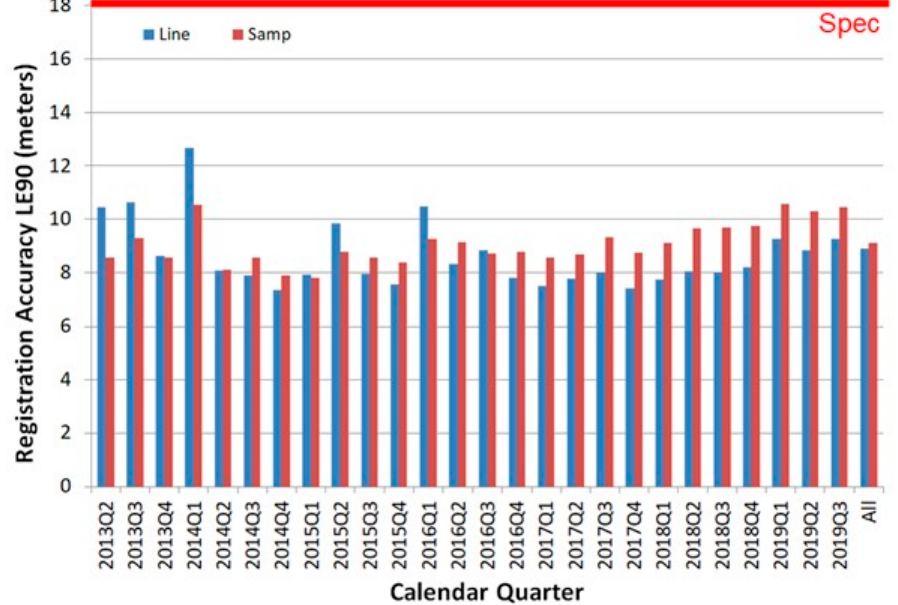
Figure 12. TIRS instrument, band 10 to band 11, alignment. The within instrument band-to-band alignment of TIRS was below specifications throughout its mission. LE90 is linear error with 90% confidence.